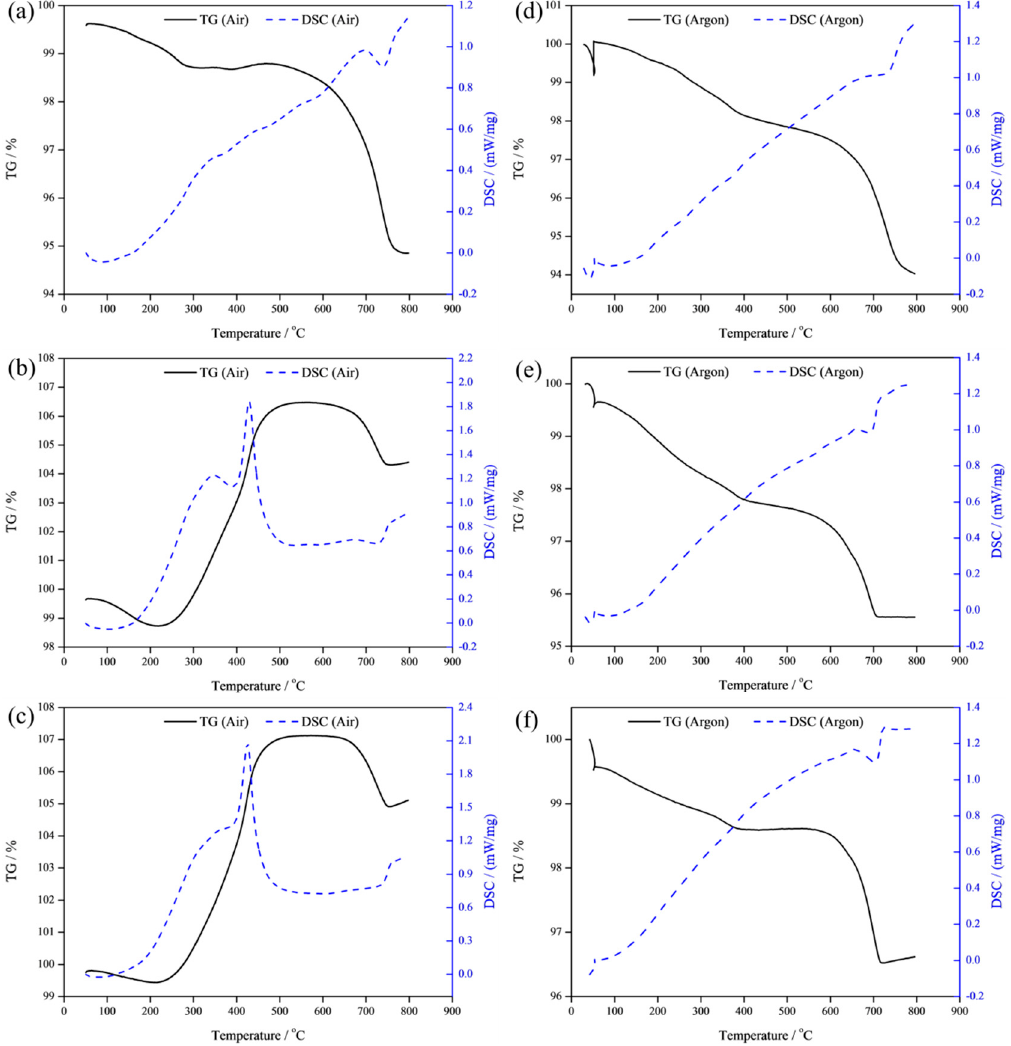
Figure 3. TG-DSC curves of the three BOS filter cakes in air and argon atmospheres: ( a ) BOS-1, in air; ( b ) BOS-2, in air; ( c ) BOS-3, in air; ( d ) BOS-1, in argon; ( e ) BOS-2, in argon; ( f ) BOS-3, in argon.